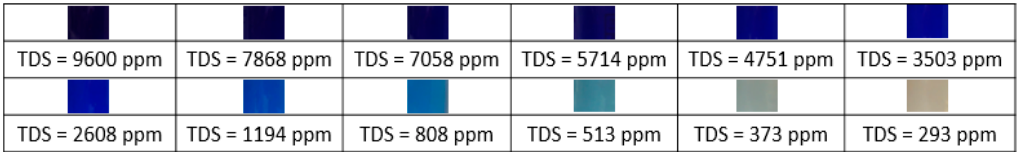
Figure 1. RGB Color matrix for SSS after successive dilution (initial salinity of 9600 ppm).